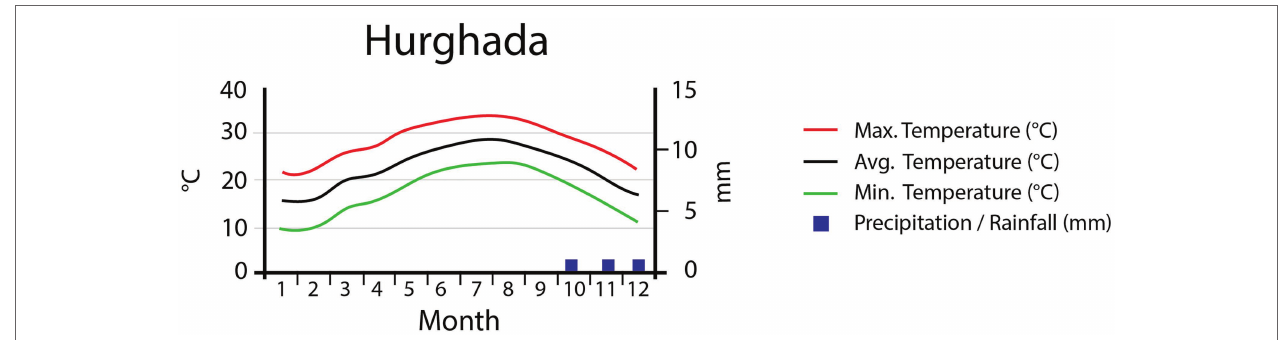
FIGURE 1 | Climate diagram for the study area showing the monthly maximum, mean, and minimum temperatures ( ° C) and the mean monthly precipitation